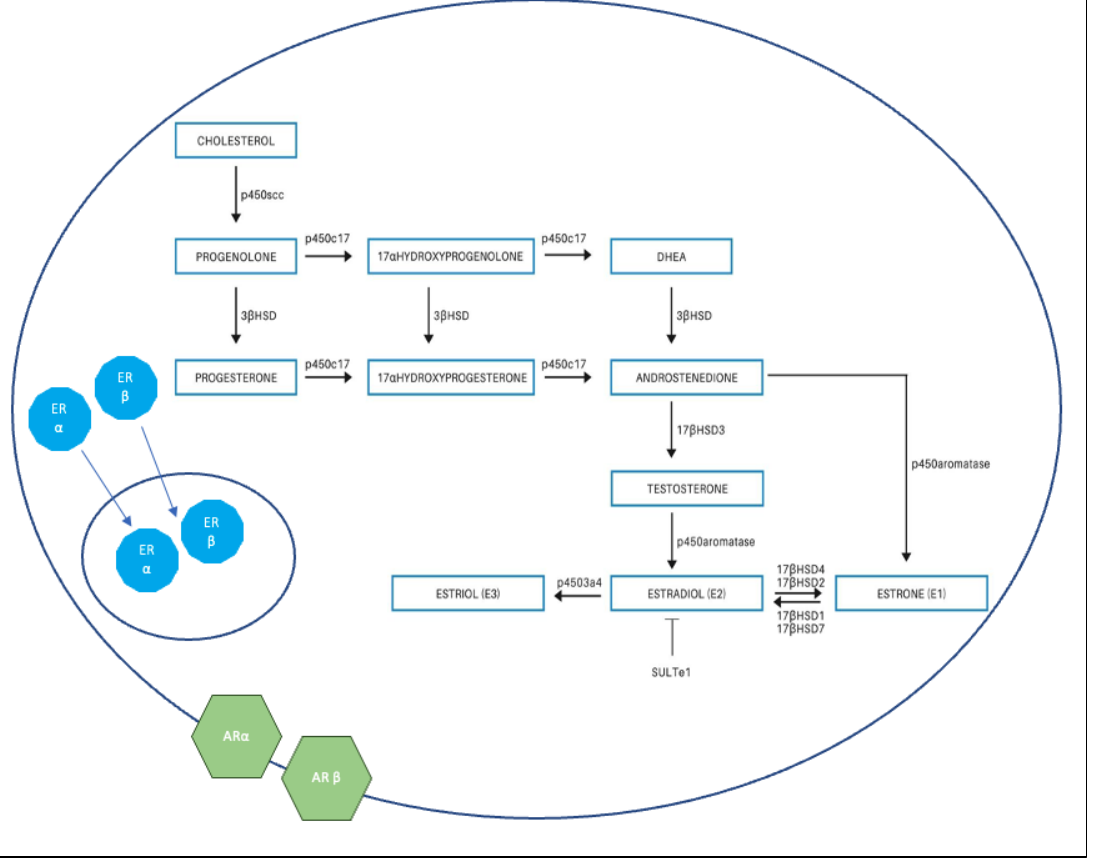
Figure 1. Conversion of androgens to estrogens in the cell. Estrogen receptor alpha (ERα) and beta (ERß) are nuclear hormone receptors located in the cytoplasm and upon ligand binding move into the nucleus. They regulate local adipose tissue metabolism. Adrenergic receptor alpha (ARa) and beta (ARß) are catecholamine receptors for the sympathetic nervous system and are localized to the cell membrane. AR2a negatively regulates lipolysis, whereas AR2ß positively regulates lipolysis. P450C17 catalyzes the conversion of pregnenolone and progesterone and is required to synthesize sex hormones. P450 Aromatase catalyzes the conversion of androgens to estrogens and is the rate-limiting enzyme of estrogen synthesis. 17ßHSD2 and 17ßHSD4 catalyze the conversion of E2 to E1. 17ßHSD1 and 17ßHSD7 catalyze the conversion of E1 to E2. Estrogen sulfotransferase (SULT1E1) sulfonates estrogens to inactive estrogen sulfates.